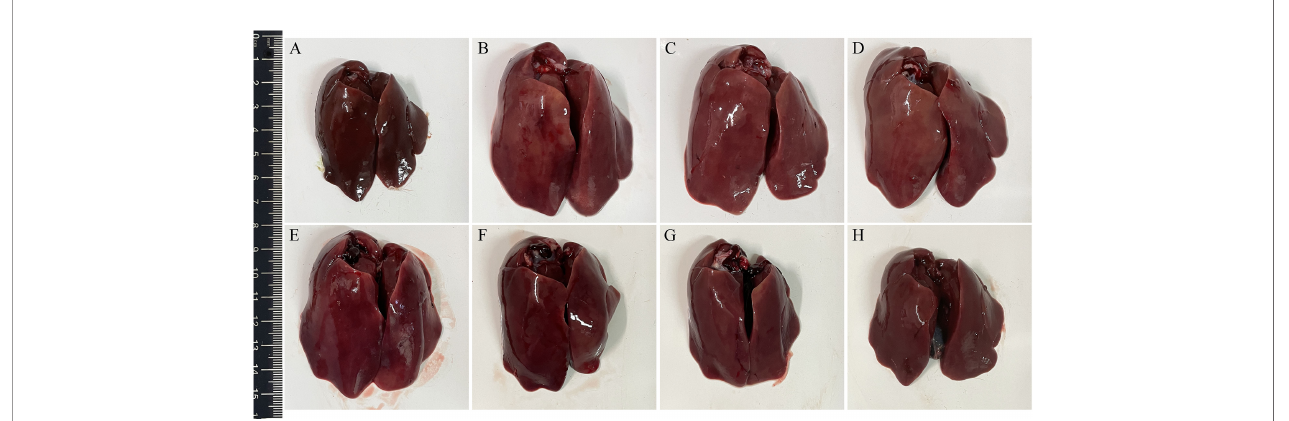
FIGURE 10 | Gross pathological changes in livers of chickens from each group. The livers of chickens in negative control group were normal (A) . Pathological changes in infection control (B) , L. lactis /pTX8048 (C) , and E. faecalis /pTX8048 (D) groups were noticeable, showing swollen and friable, with multifocal areas of necrosis. Only slight pathological lesions were observed in groups L. lactis /pTX8048-Fiber2-CWA (E) , L. lactis /pTX8048-DCpep-Fiber2-CWA (F) , E. faecalis / pTX8048-Fiber2-CWA, (G) and E. faecalis /pTX8048-DCpep-Fiber2-CWA (H) .